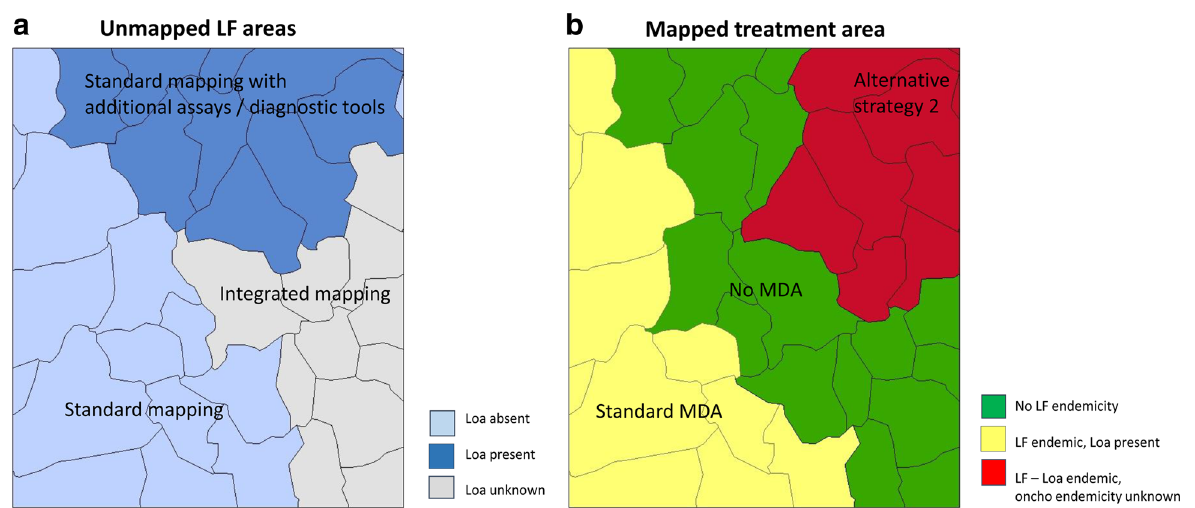
Fig. 3 Example of maps highlighting mapping and treatment requirements in LF – Loa co-endemic area. (a) Unmapped LF areas (b) Mapped treatment